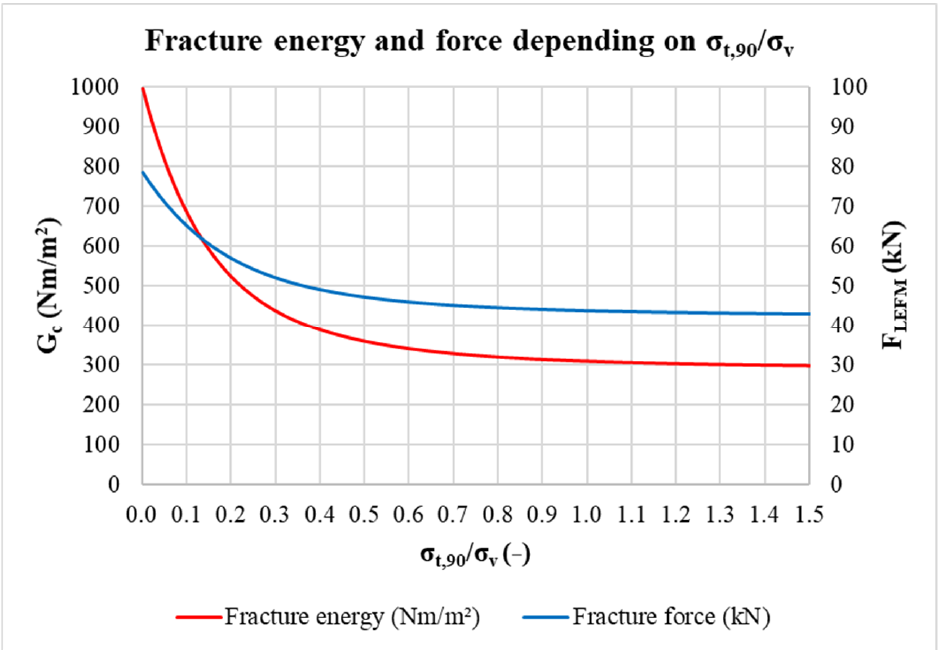
Figure 23. The fracture energy and force depending on the ratio of tensile stress perpendicular to the grain to shear stress.